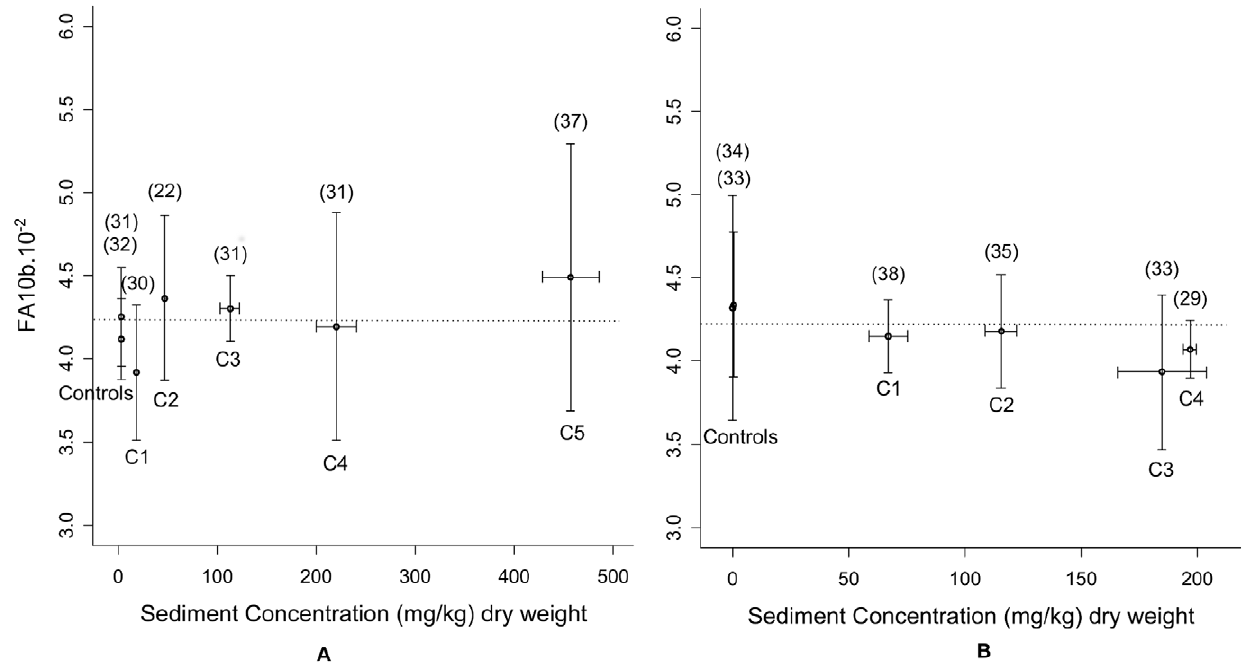
Figure 5. FA10b variations for lead and 4-NP bioassays. Lead bioassays (A) and 4-NP bioassays (B). Error bars indicate standard deviations between replicate test aquaria. Mean replicate sample size is indicated in brackets. Doted lines indicate FA mean value.